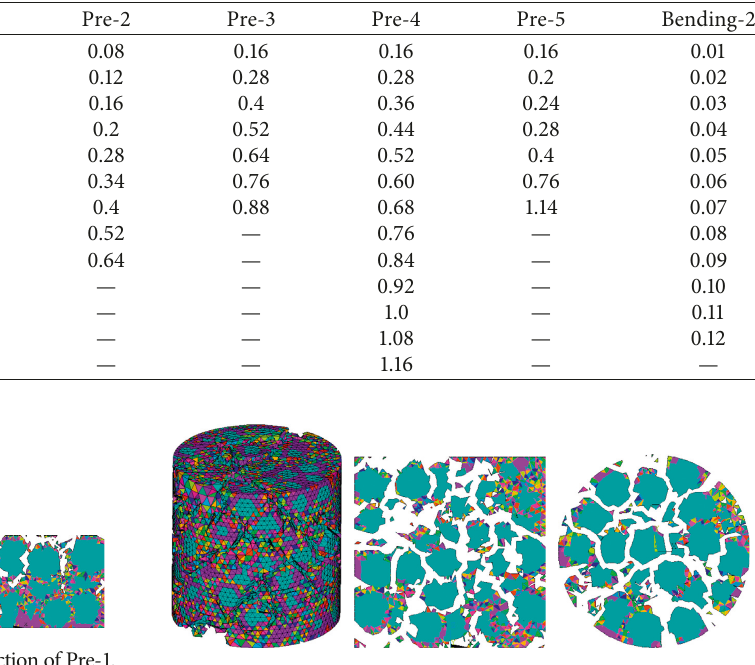
Figure 2: The damaged specimen and damaged cross section of